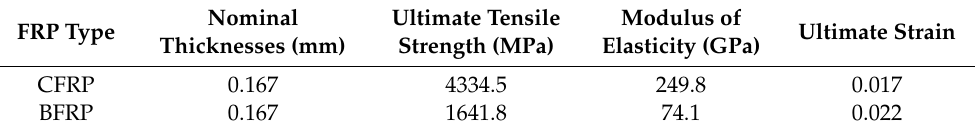
Table 2. Material properties of the FRP.